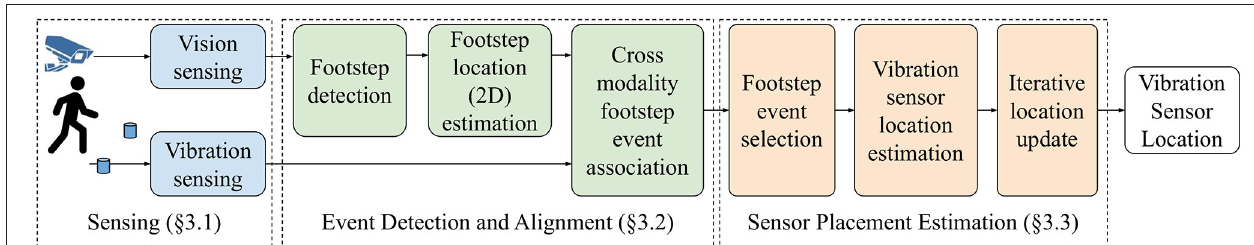
FIGURE 2 | System overview.